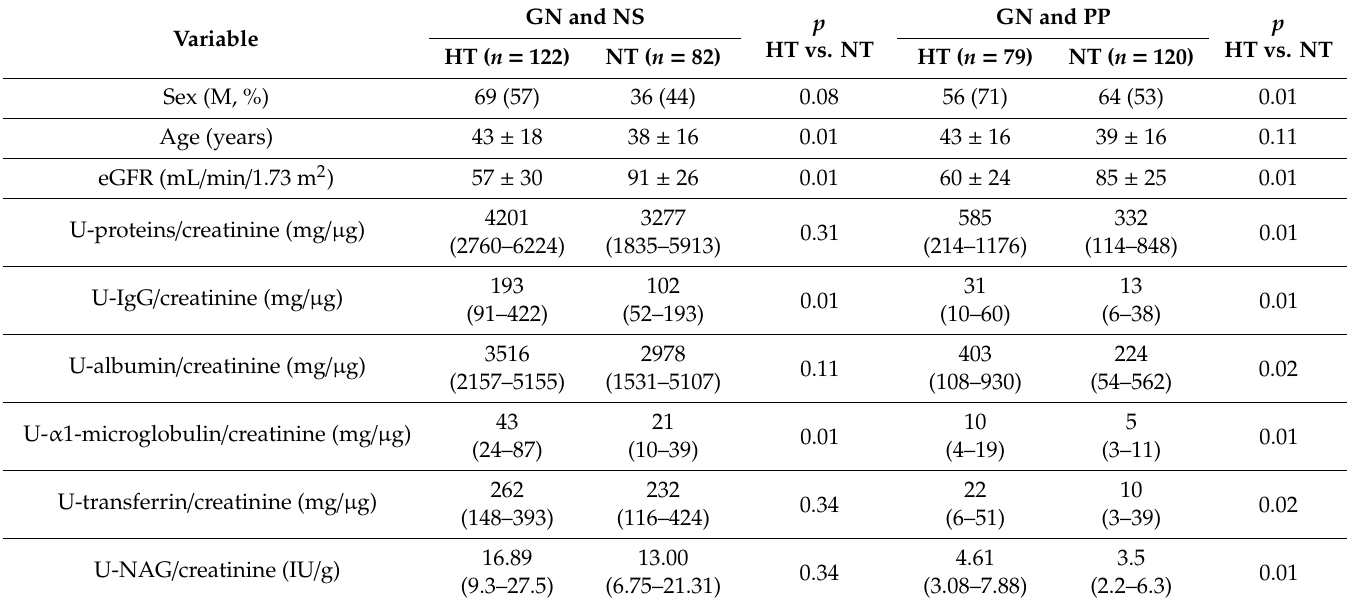
Table A1. Renal function in GN patients with / without arterial